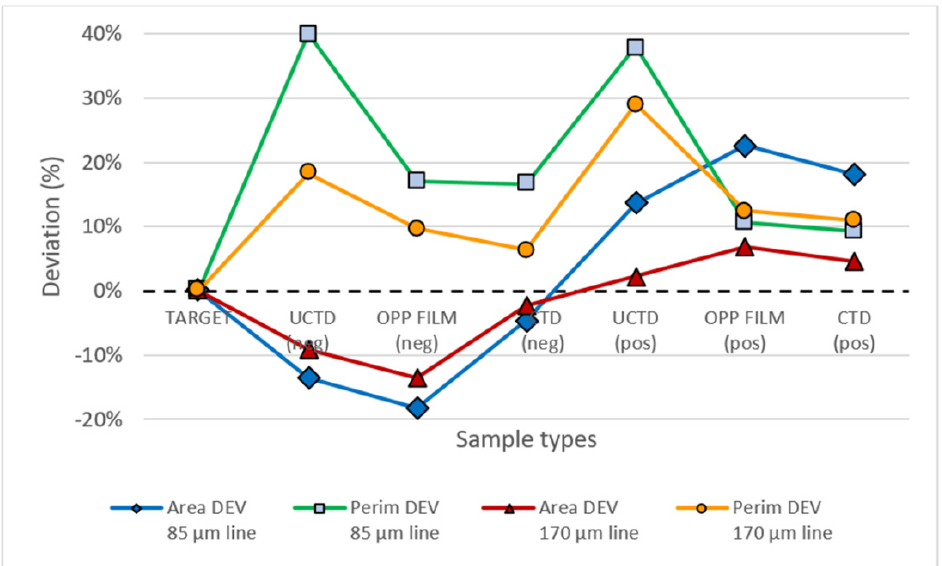
Figure 4. Deviation of area and perimeter (%) for lines thickness of 85 μ m and 170 μ m printed in positive and negative shape on three different printing substrates.